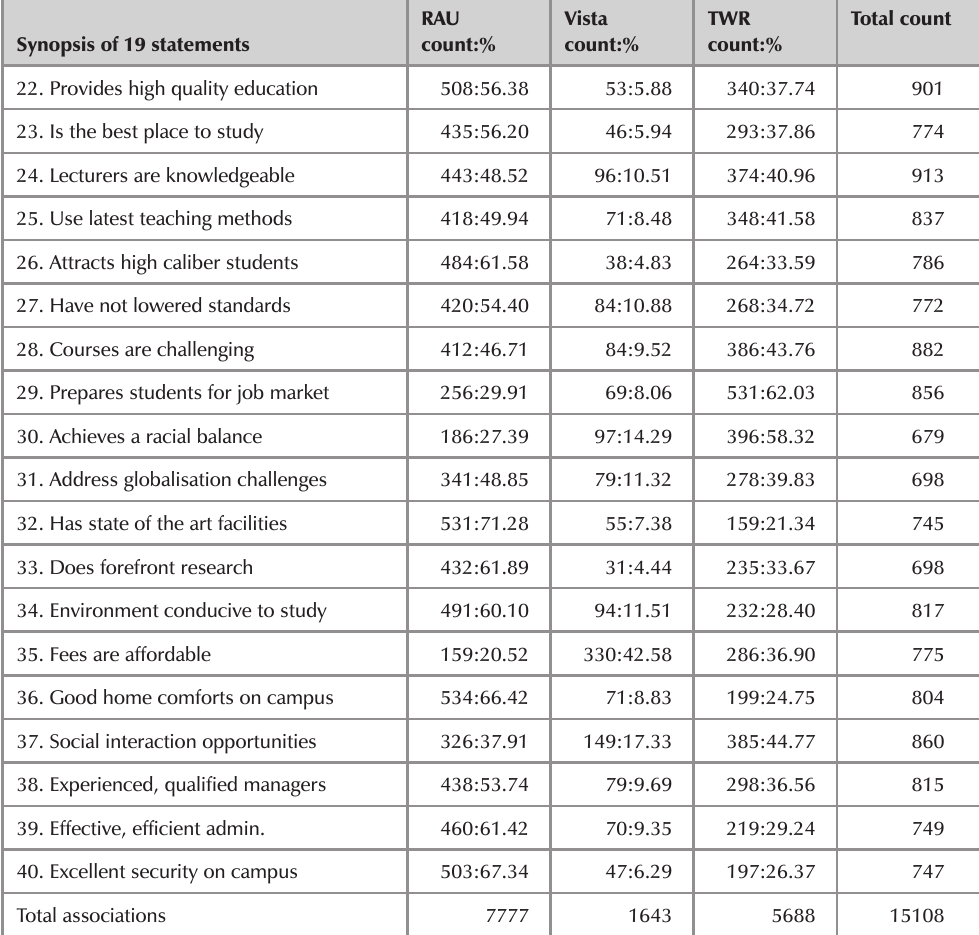
Association table: Frequency of associations for dimensions 1 and